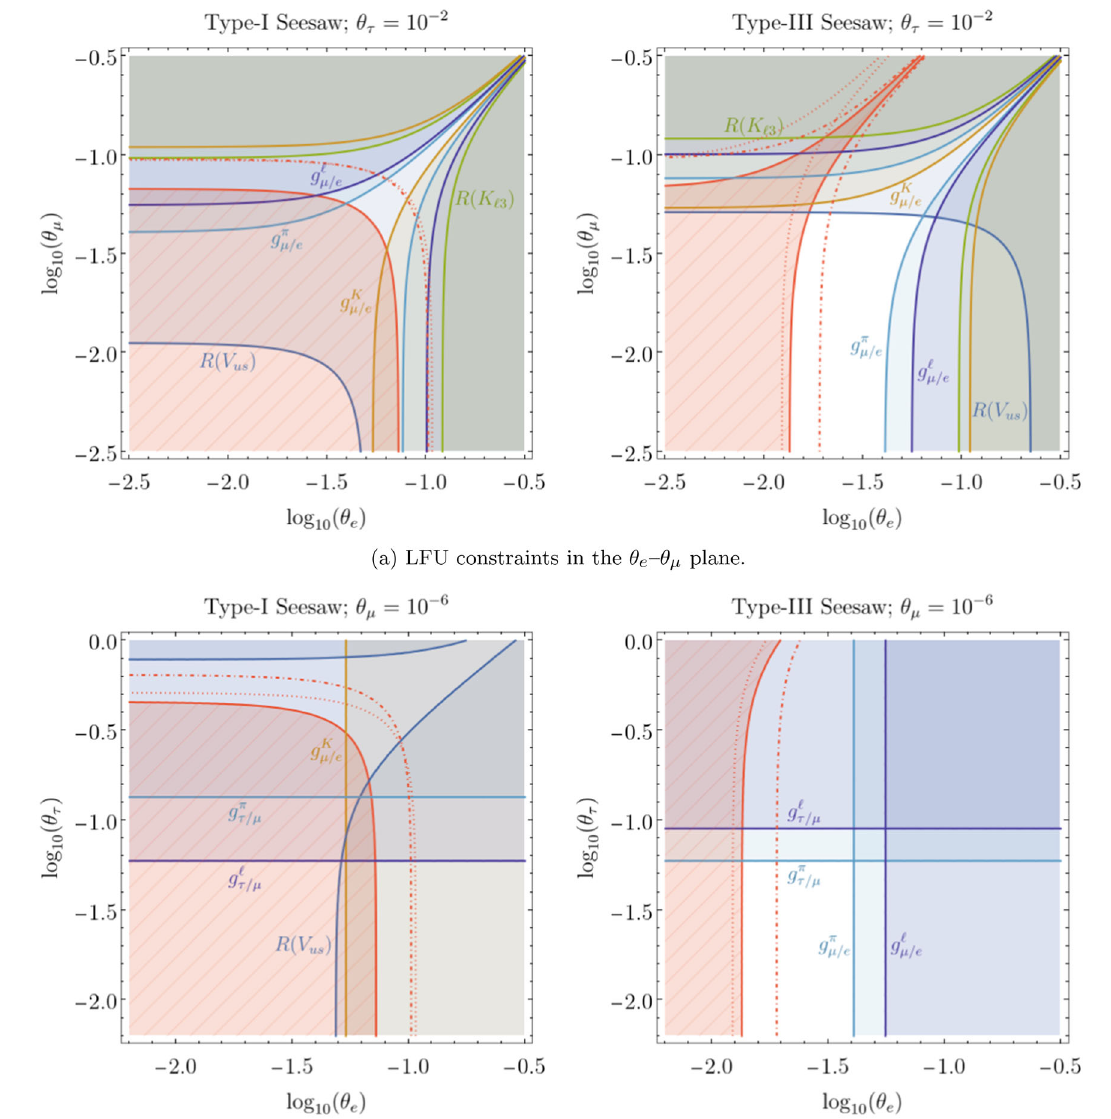
Fig. 4 CurrentconstraintsarisingfromLFUratiosat2 σ incomparison with projected sensitivities of precision Higgsstrahlung measurements. The red-ruled regions indicate | (cid:8)σ/σ | < 0 . 5% at